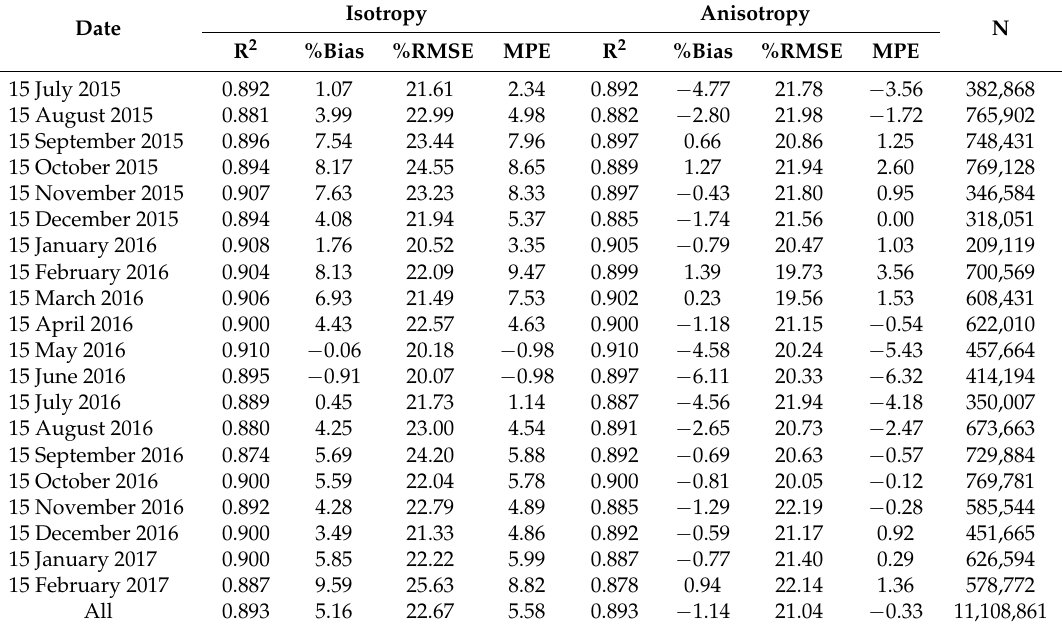
Table 3. Statistical results of TOA albedo using Himawari-8/AHI and Terra, Aqua, and S-NPP/CERES